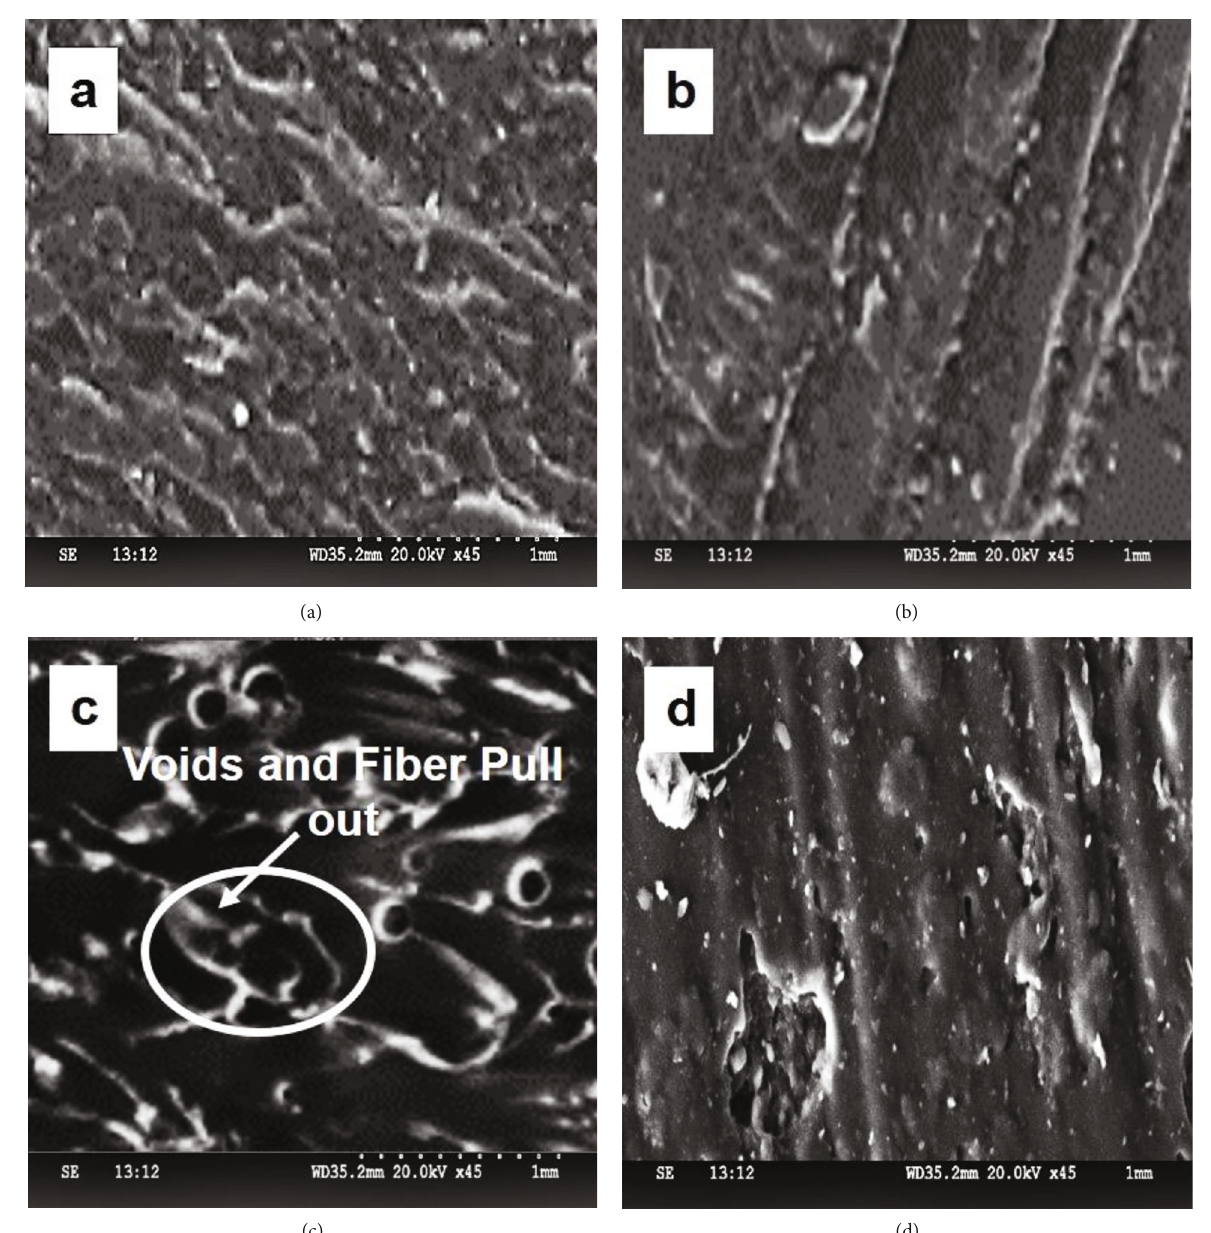
Figure 6: Microstructural images of coir/pineapple/Al